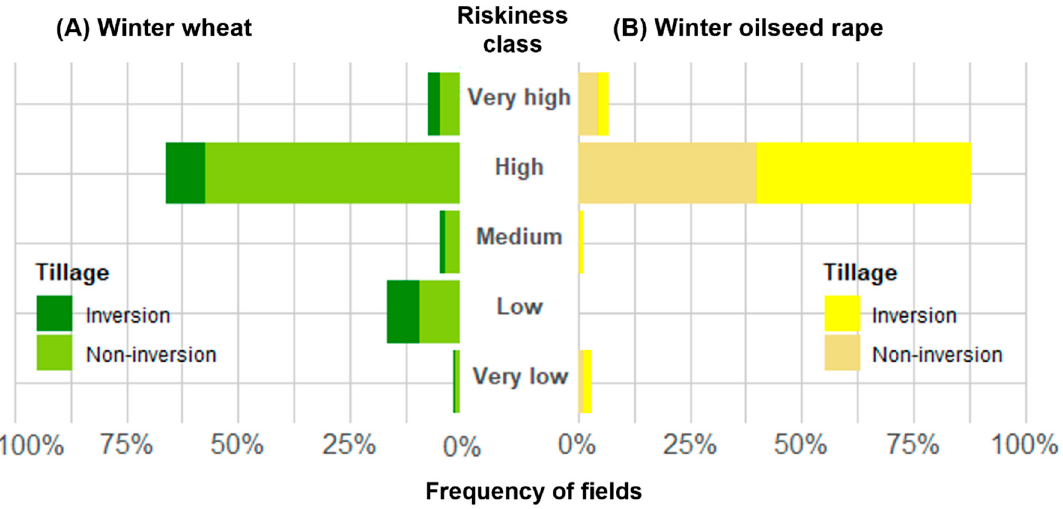
Figure 2. Frequency (%) of fields per riskiness class in ( A ) winter wheat and ( B ) winter oilseed rape.